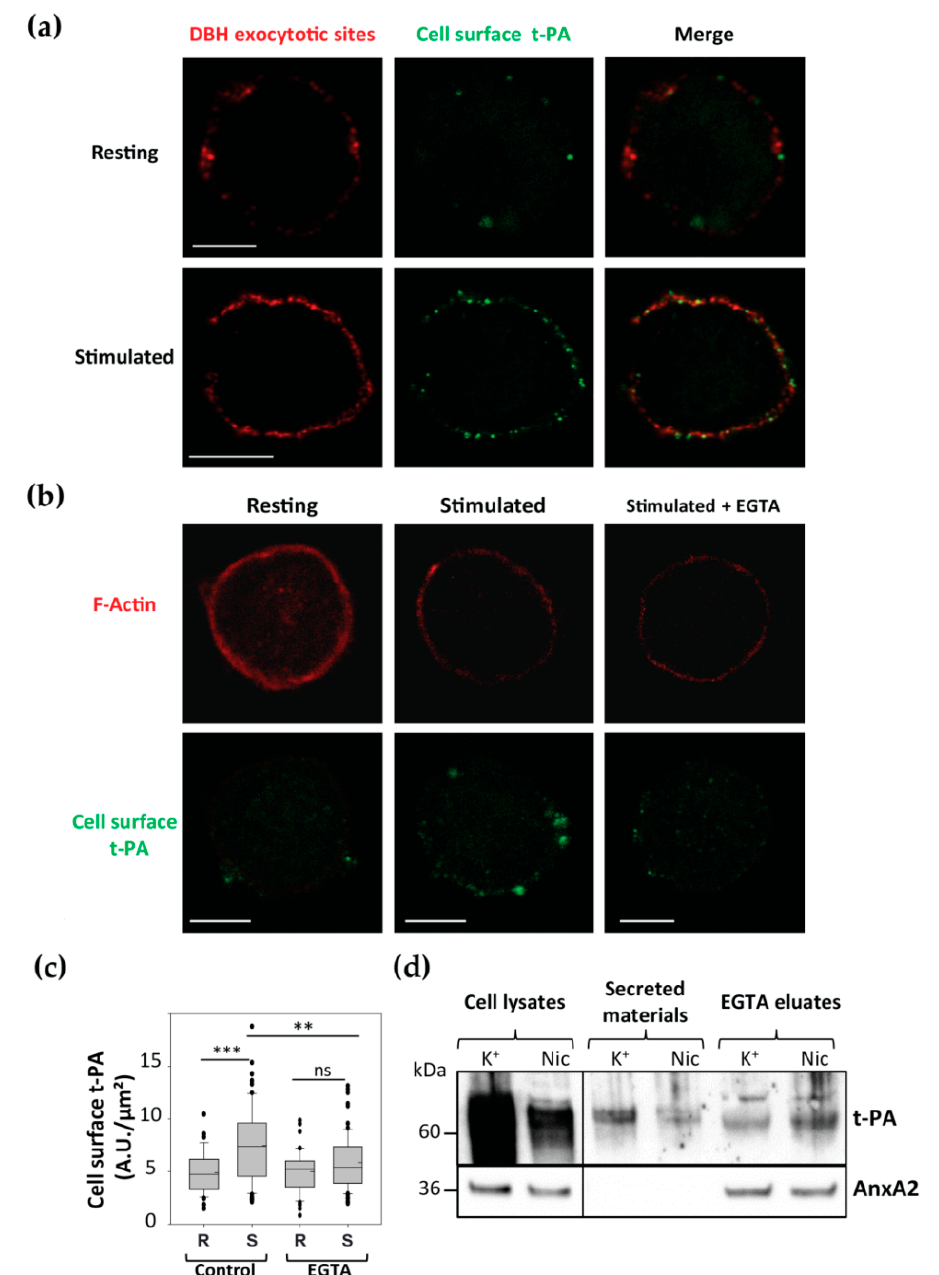
Figure 4. Tissue plasminogen activator (t-PA) is present on the outer leaflet of the plasma membrane of stimulated chromaffin cells. ( a ) Dual labeling of cell surface t-PA and exocytotic sites. Cells were stimulated with nicotine 20 µM in the presence of anti-t-PA and anti-DBH antibodies. Cells were then fixed and incubated with secondary antibodies coupled to Alexa Fluor ® 488 and Alexa Fluor ® 551, respectively. Confocal images were recorded in the same optical section and with the same parameters of lasers and photomultipliers. Scale bar: 10 µM. ( b ) The t-PA labeling on the surface of chromaffin cells in the resting condition (R), stimulated with 20 µM nicotine without (S) or after EGTA wash (S + EGTA). Anti-t-PA antibodies were revealed with Alexa Fluor ® 488-conjugated anti-rabbit antibodies and F-actin with TRITC-phalloidin to visualize the cell shape. Confocal images were